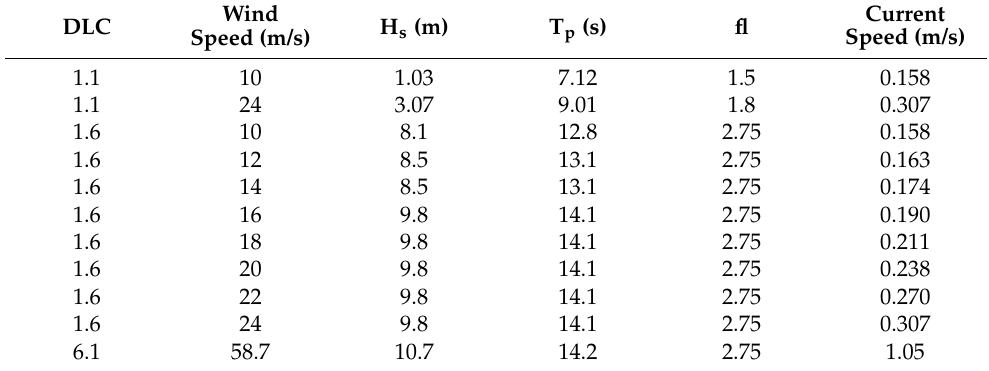
Table 17. Environmental conditions for DLCs included in simulation.